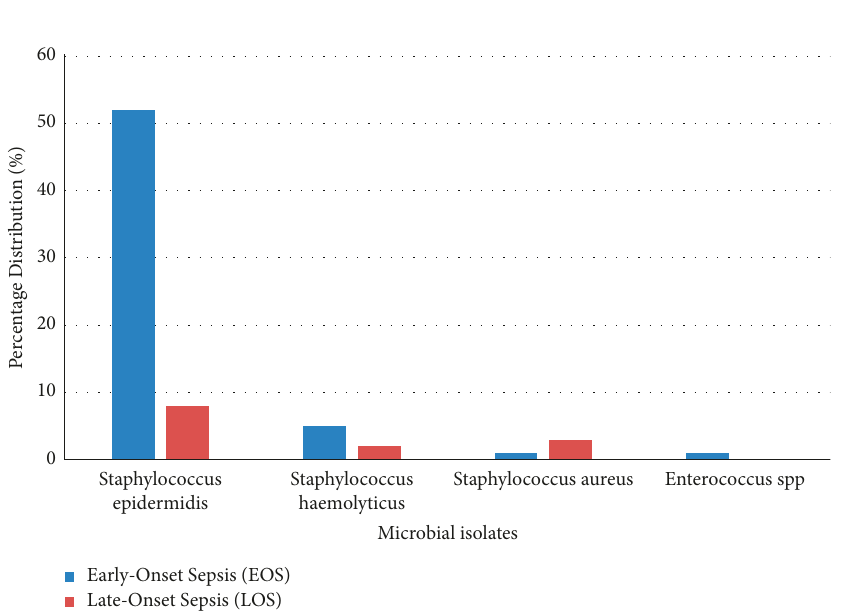
Figure 1: Distribution of Gram-positive bacteria in EOS and